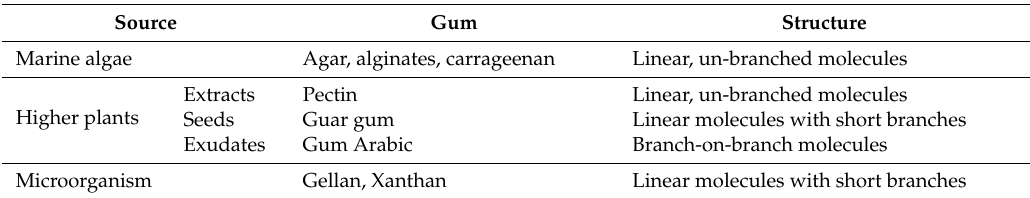
Table 2. Sources of common gums and their overall structure.